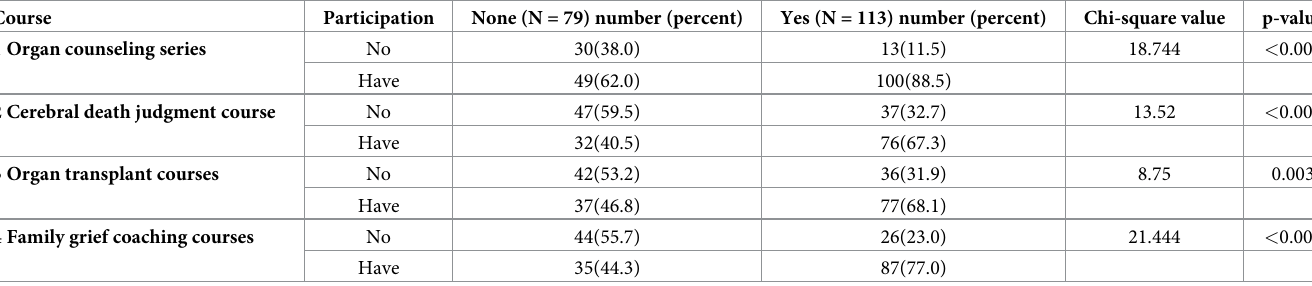
Table 5. Relationship between basic attributes and participation in organ counseling